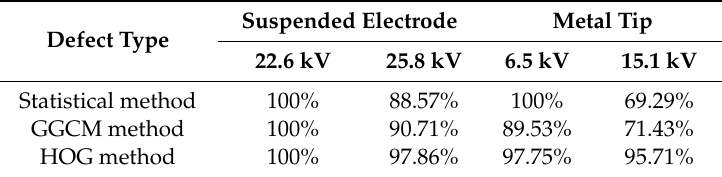
Table 6. Recognition result at di ff erent voltages